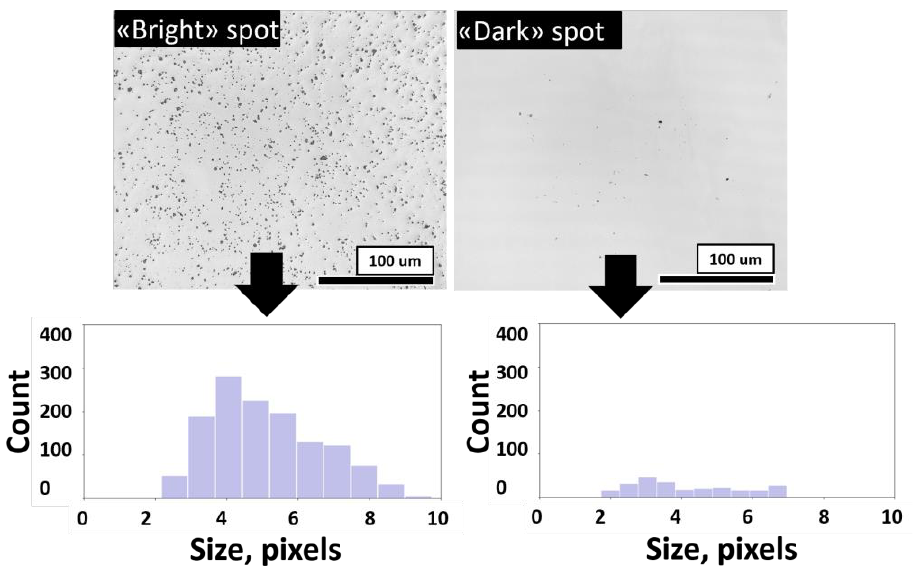
Figure 20. Top—laser confocal images of bright ( left ) and dark ( right ) spots after 60 min of polishing. Bottom—calculated distribution of abrasives for bright ( left ) and dark ( right ) spots.